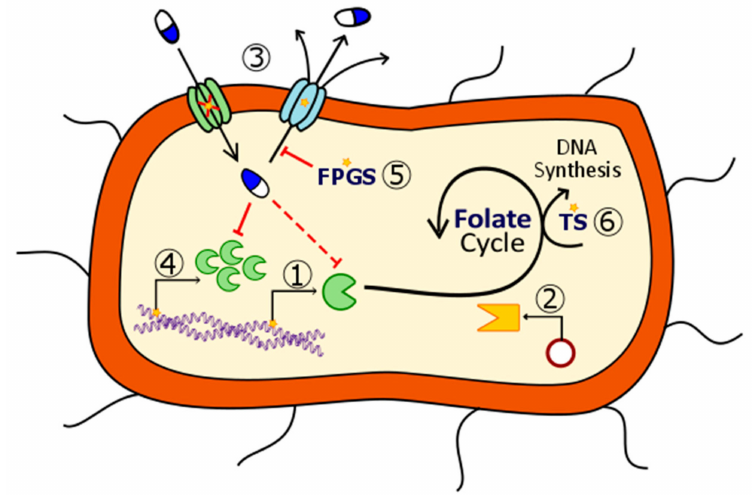
Figure 9. Resistance mechanisms against antifolates. Stars indicate possible mutations associated with the appearance of resistance against antifolates. Some mechanisms apply to eukaryotic cells too. Each number indicates the resistance mechanism described in the text: 1. Mutations a ff ecting the genes that code the antifolates-targeted enzymes; 2. Emergence of novel resistant isoforms of the antifolates-targeted enzymes; 3. Reduction in cell permeability and increase in e ffl ux proteins; 4. Overexpression of target enzymes; 5. Deregulation of polyglutamation; and 6. Thymine